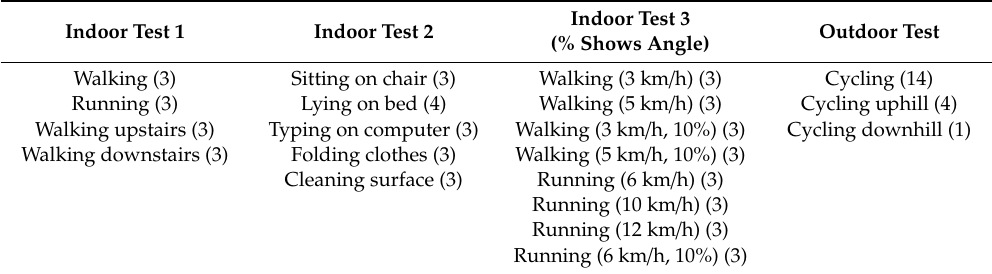
Table 1. Conducted activities and their duration in